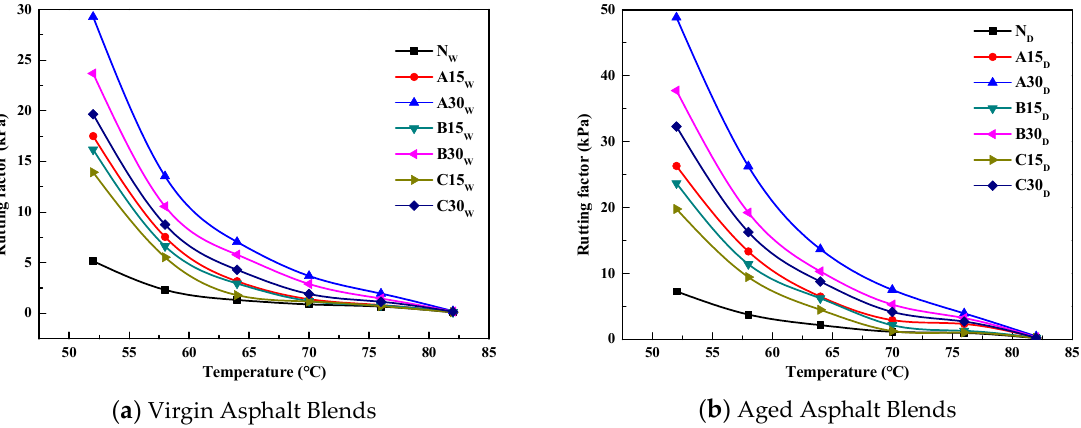
Figure 5. The results of the rutting factor versus temperature for unaged ( a ) and short-term aged ( b ) asphalts.